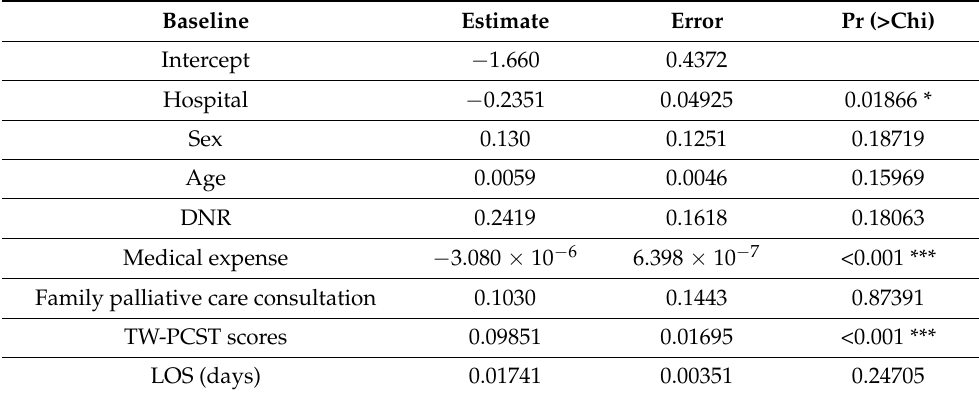
Table 5. The value of coefficient by logistic regression model.